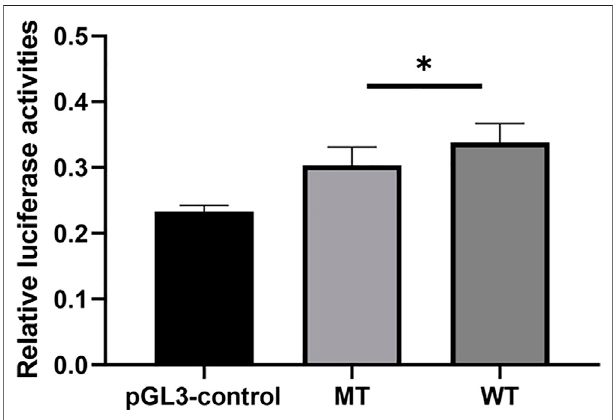
FIGURE 6 | The effect of rs150703258 on gene transcriptional activity. The relative fi re fl y luciferase activities were compared between insertion construct group (pGL3-MT) and deletion construct group (pGL3-WT) in 293T cell lines. Cells transfected with pGL3-WT exhibited a signi fi cantly higher luciferase activity as compared with cells transfected with pGL3-MT (* p < 0.05).